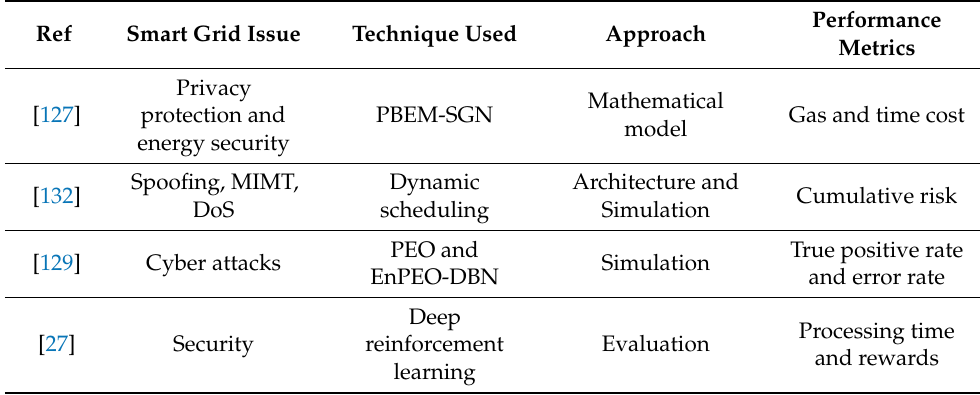
Table 3. Summary of key security areas regarding the application of Edge Computing in